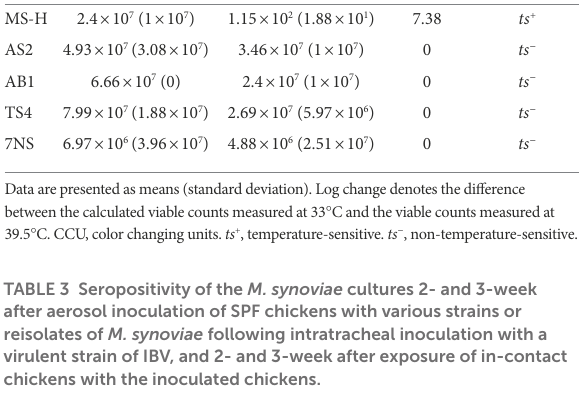
TABLE 2 Viable counts of Mycoplasma synoviae strains/reisolates (CCU/mL) in this study at permissive (33 ° C) and non-permissive (39.5 ° C) temperatures.